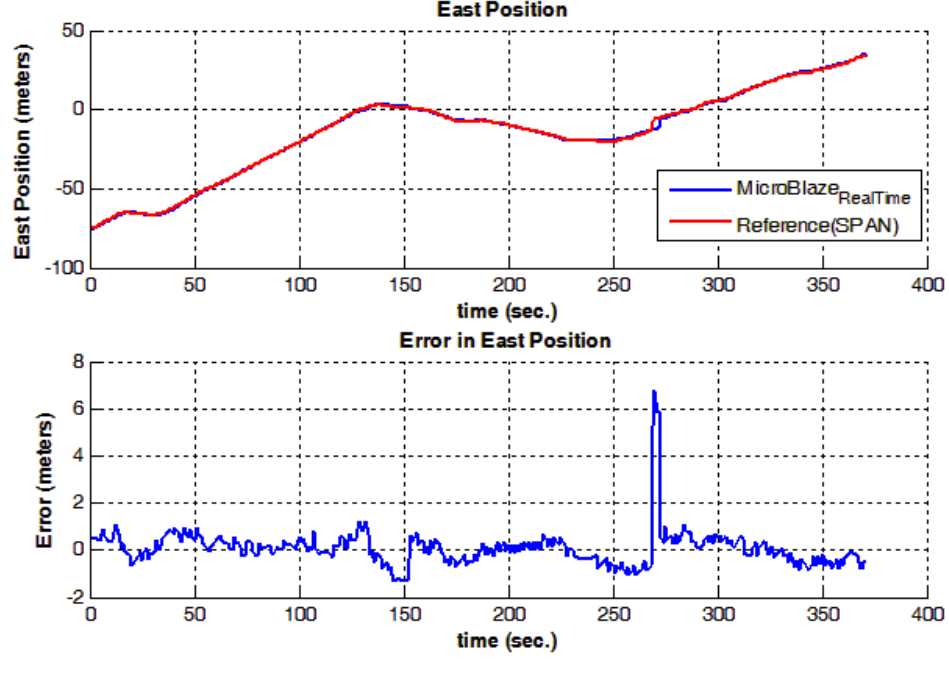
Figure 19. East Position Solution and Error in East Position between the Real-time and Reference Solutions during Trajectory